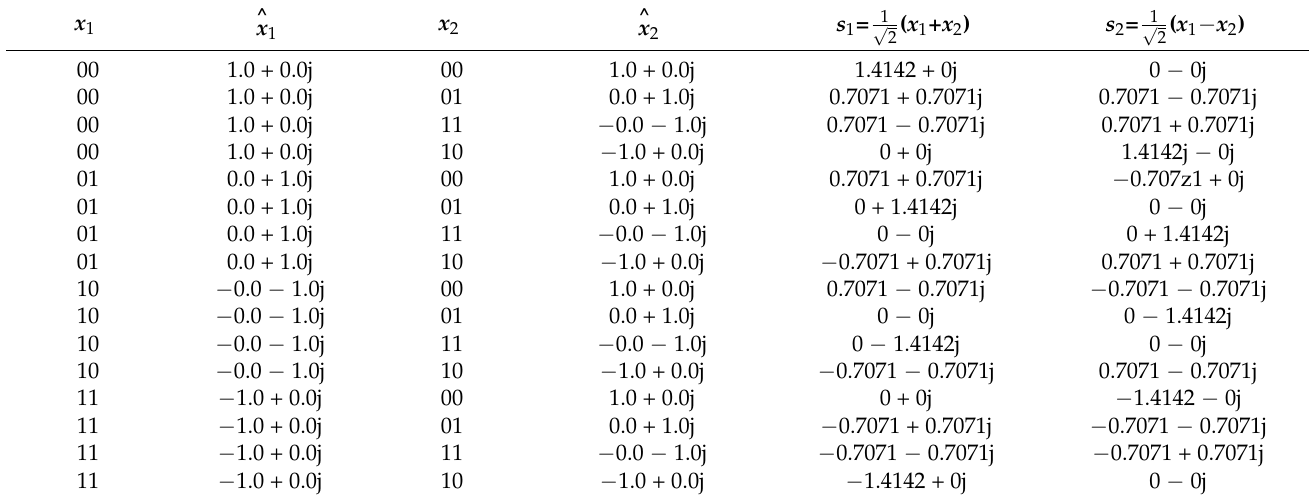
Table 2. New Constellation Points after Application of